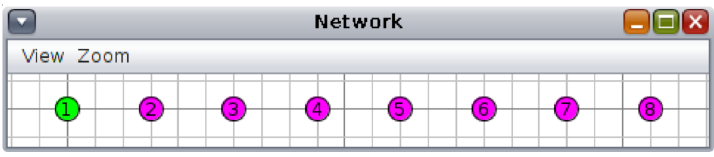
Figure 3. Network with linear topology ( N = 8 nodes) modeled in the Cooja